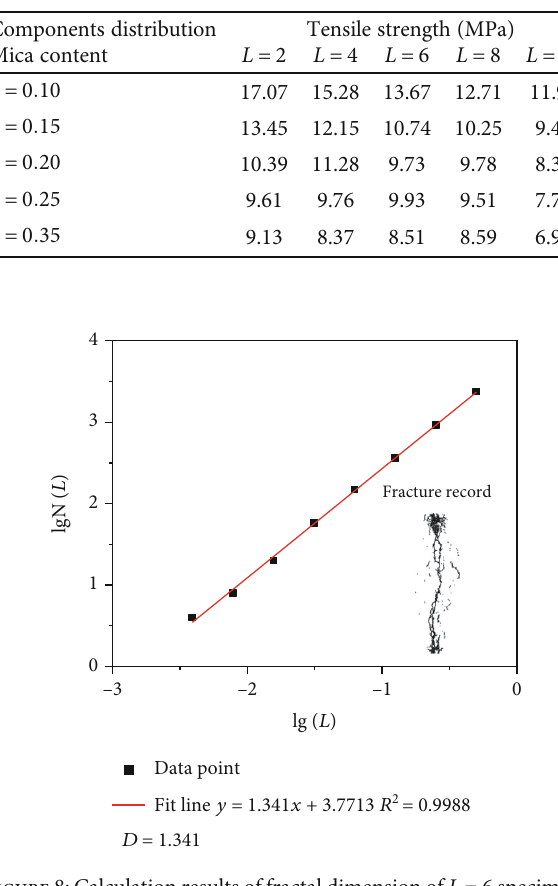
Figure 8: Calculation results of fractal dimension of L = 6